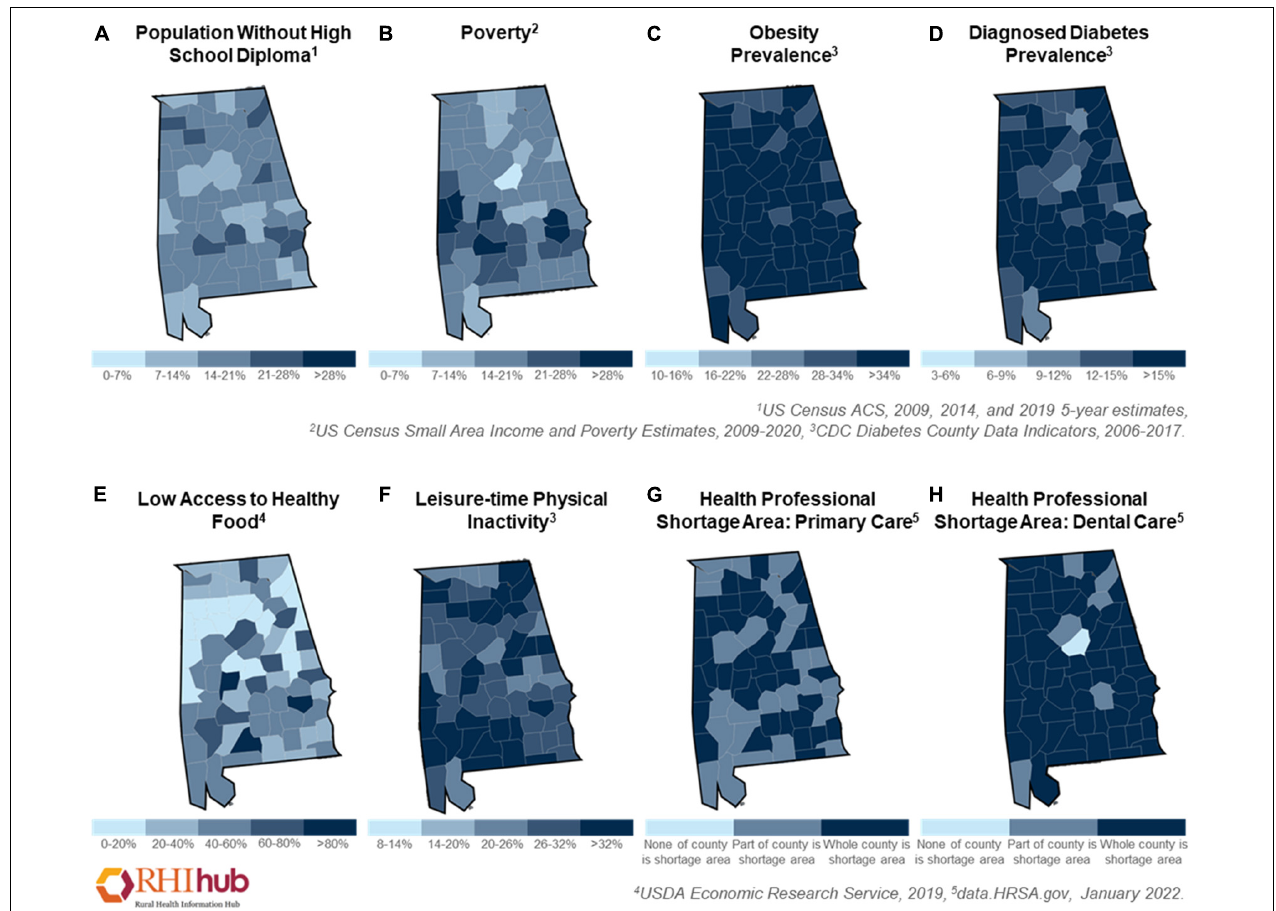
FIGURE 2 | Health disparities in Alabama. The disparities prevalence of Alabamians in 2006–2022 as shown by (A) population without school diploma, (B) poverty, (C) the prevalence of obesity, (D) the prevalence of diagnosed diabetes, (E) low access to healthy food, (F) leisure-time physical inactivity, (G) health professional shortage area in primary care, and (H) health professional shortage area in dental care. These figures were generated using Rural Health Information Hub (RHIhub,